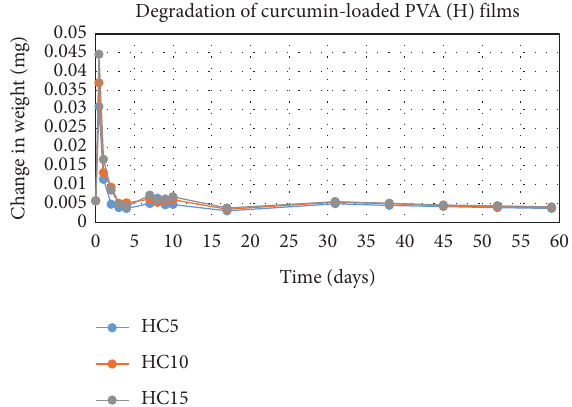
Figure 2: Degradation of curcumin-loaded PVA (H) films.